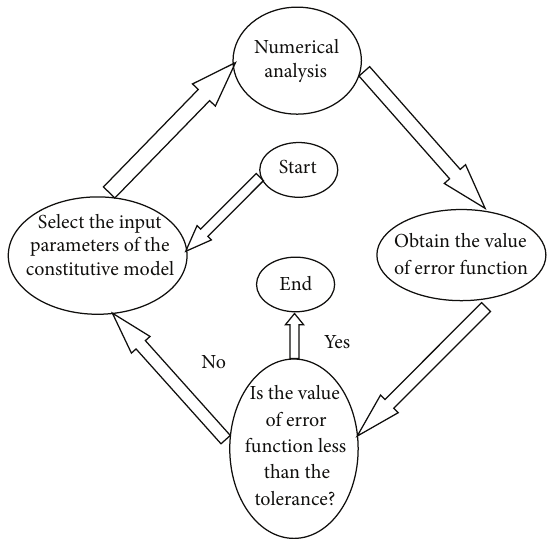
Figure 6: General inverse analysis diagram for calibration of soil constitutive models.